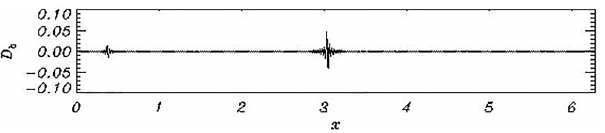
Figure 10. Example of the energy input due to the breaking D b (x) .